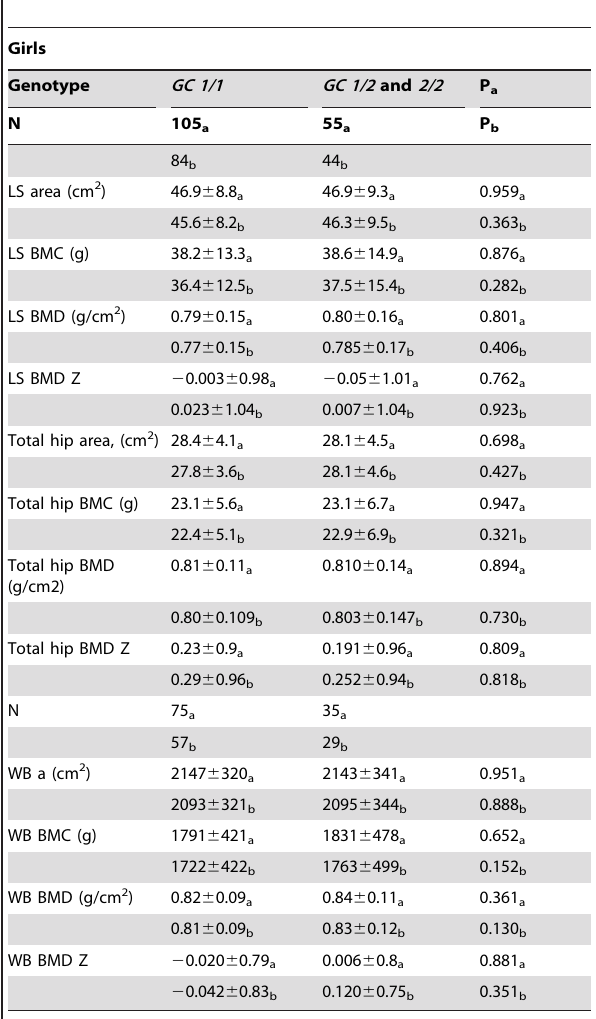
Table 2. Bone variables for genotype 1/1 and genotypes Gc 1/2 and 2/2 combined in the whole study population measured with DXA.